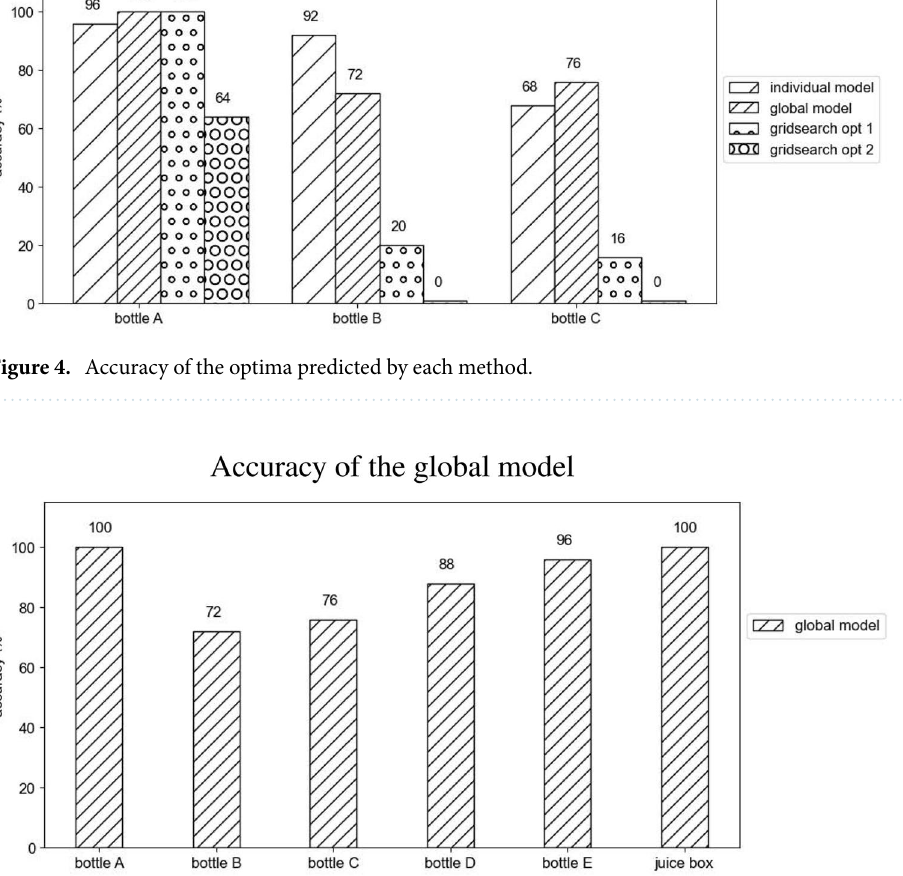
Figure 5. Accuracy of the optima predicted by the global model on each object. The global model is obtained merging the observations made during the training of the individual models for bottles A, B and C. The remaining objects are completely new to the